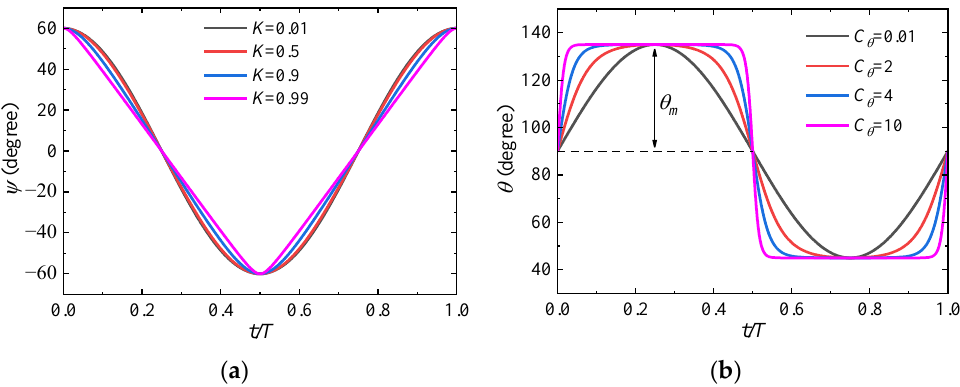
Figure 3. Flapping kinematics of different parameters. ( a ) Sweeping angle of different K . ( b ) Pitching angle of different C θ . T is the flapping period.